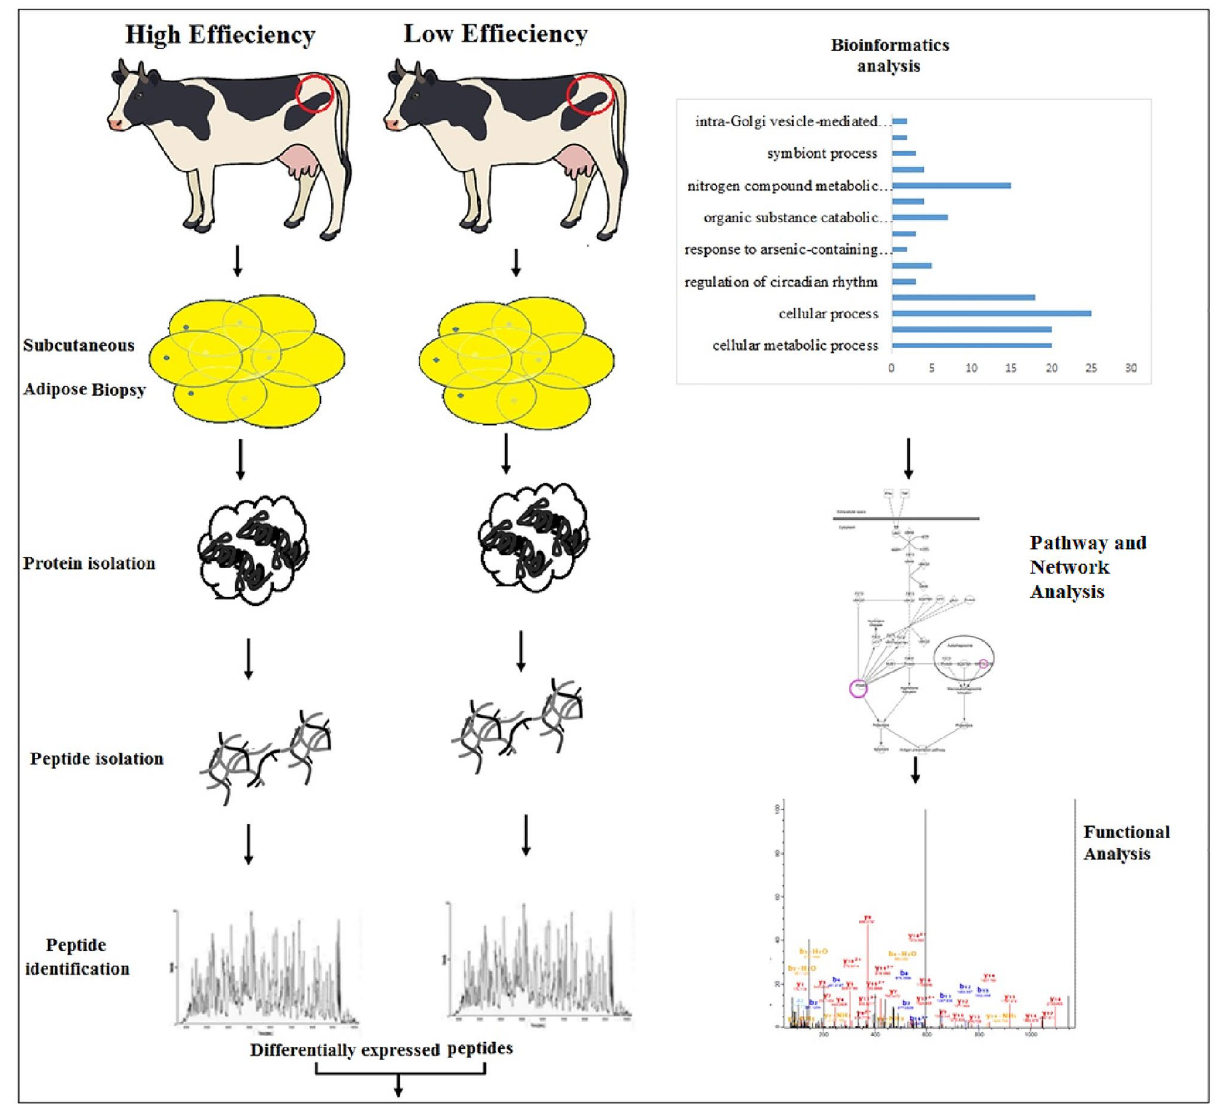
Figure 1. Workflow used to study proteomic analysis of AT in HEF versus LEF dairy cows. AT was isolated from HEF and LEF groups, extracted proteins from samples. Proteins were digested and peptides were identified for the differential expression. Bioinformatic analysis and network analysis was performed to identify the FE related pathways generated by IPA (Qiagen). MS/MS spectra analysis confirmed the presence of peptides in the sequences of FE related